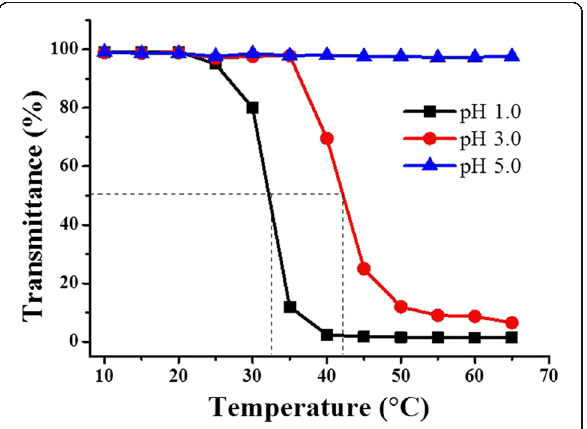
Fig. 3 Dependence of light transmittance of P(OEGDA-MAA) dispersion (1.0 mg/mL, 150 mM NaCl) on temperature at different